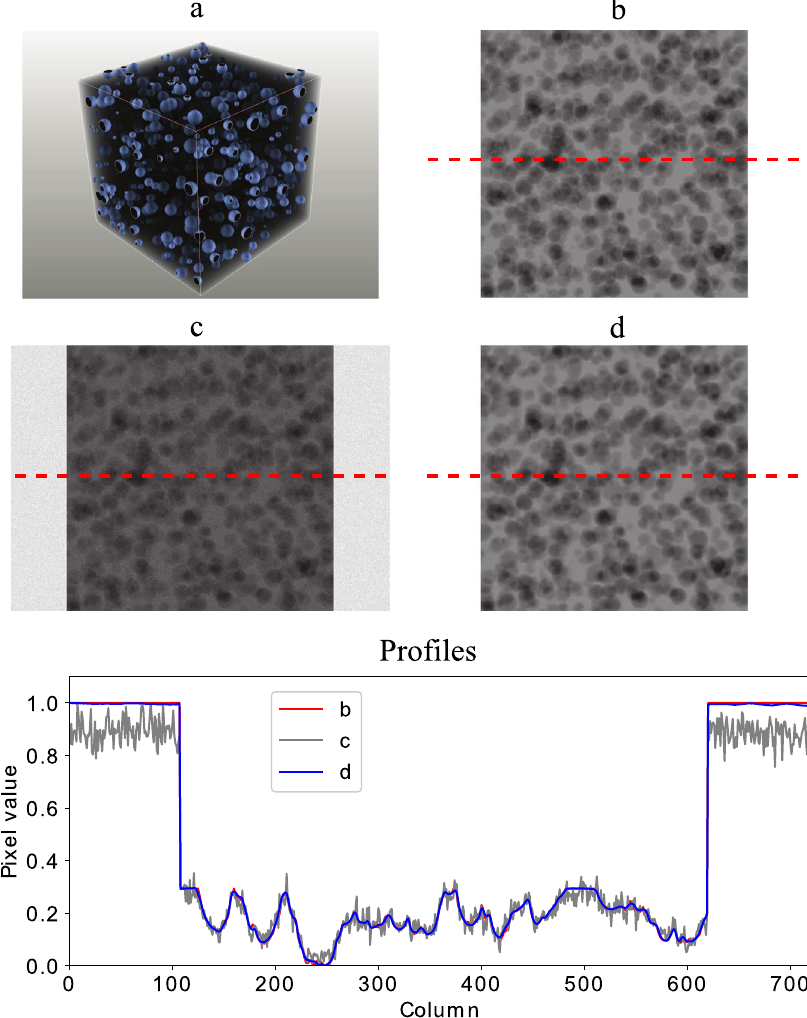
Figure 1. The simulation data to evaluate the CNN algorithm performance: ( a ) the synthetic phantom for the simulation, the empty space, the cubic and the particles have the gray values of 0, 0.3 and 1 respectively. The particle diameters are 4 to 20 voxels; ( b ) one of the original high-quality projections from the synthetic phantom, P (0); ( c ) the projection with 5% artificial noise, P n 05 . Result: ( d ) the enhanced projection by the CNN algorithm, P e 05 (0) showing the background noise perfectly removed and structural information in good agreement with ( b